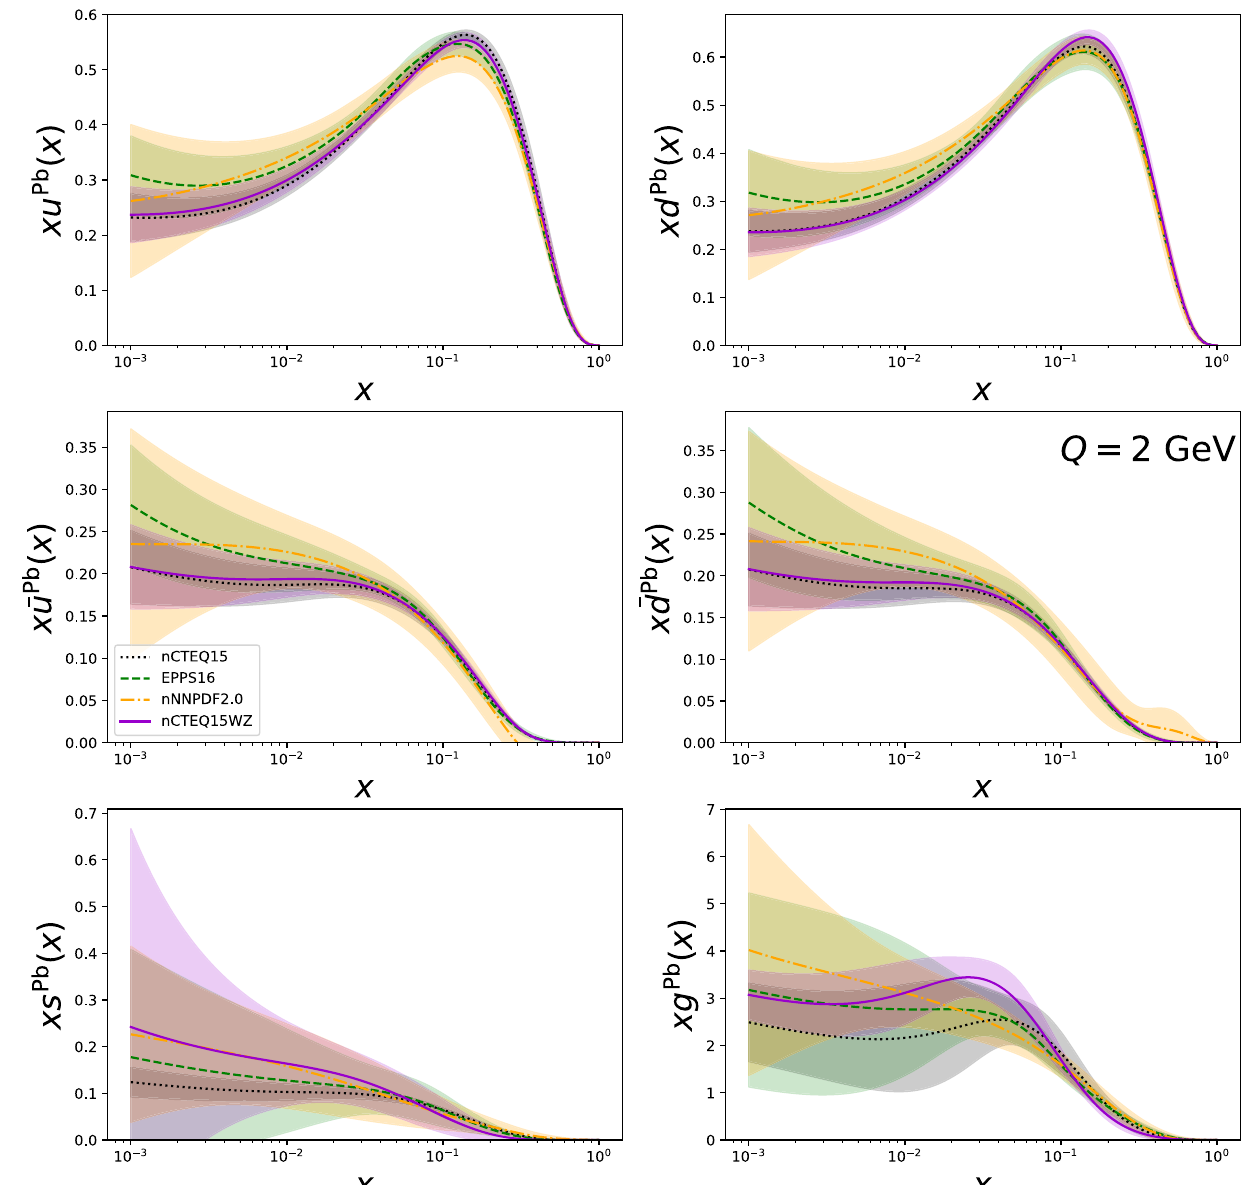
Fig. 12 Comparison of the full lead (Pb) PDFs at Q = 2GeV for nCTEQ15, EPPS16, nNNPDF2.0 and nCTEQ15WZ. The uncertainty band for nCTEQ15 is shown in gray, nCTEQ15WZ in violet, nNNPDF2.0 in yellow and EPPS16 in